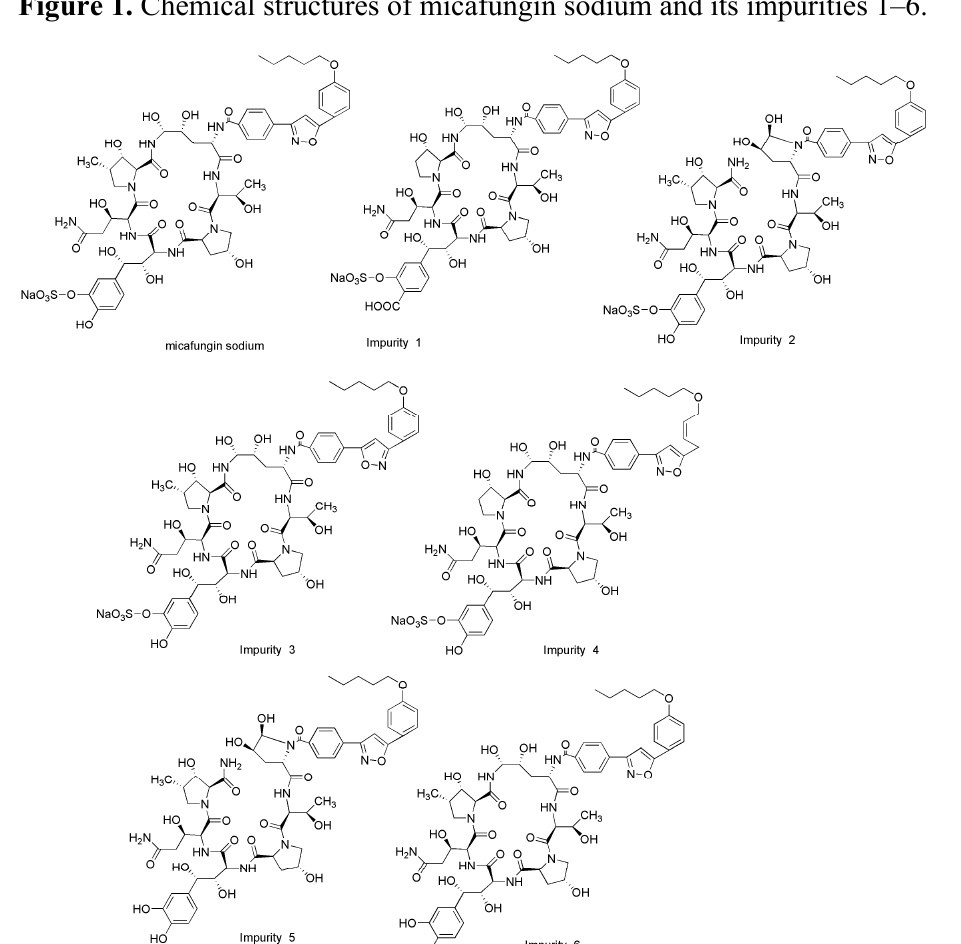
Figure 1. Chemical structures of micafungin sodium and its impurities